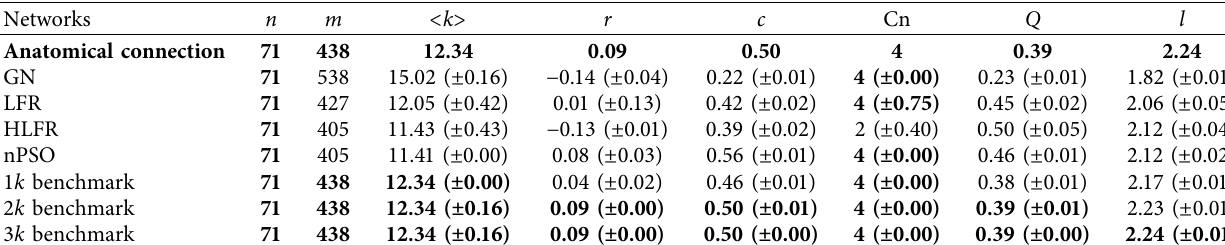
Table 2: Structural characteristics of the original anatomical connection network of the macaque cortex and seven kinds of generated benchmarks. Each data represents the average value of the characteristic calculated on 100 generated benchmarks and the data in pa- rentheses represents the corresponding standard deviation. Note that the best results closest to the original karate network on each characteristic are highlighted in bold.